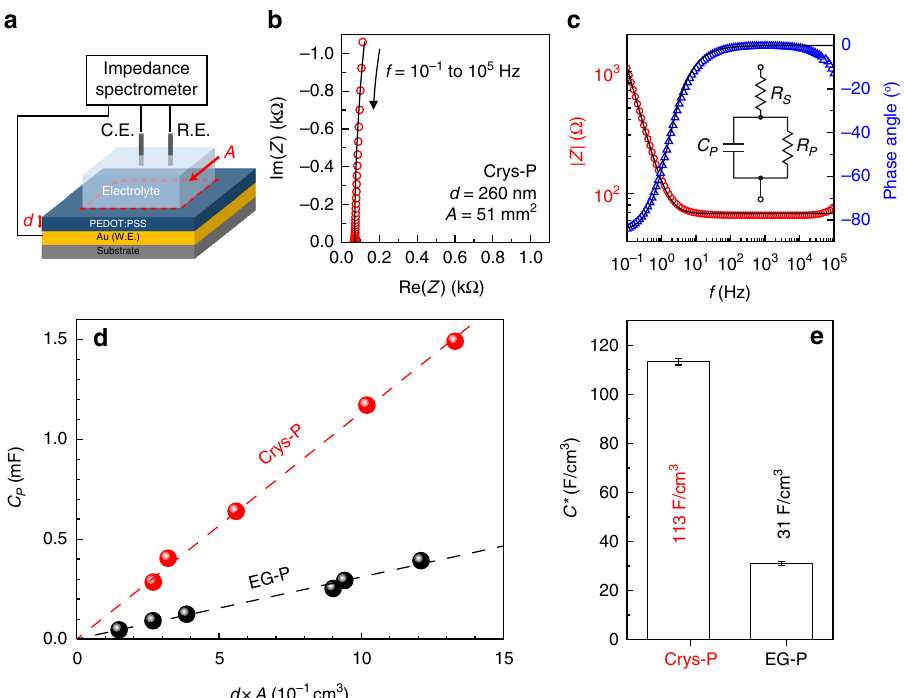
Fig. 4 Electrochemical properties of Crys-P and EG-P fi lms. a A schematic diagram of electrochemical impedance spectroscopy (EIS) measurements (C.E.: counter electrode, R.E. reference electrode (Ag/AgCl), and W.E: working electrode (PEDOT:PSS on Au). The fi lm area and thickness are denoted by ‘ A ’ and ‘ d ’ , respectively. b Nyquist and c Bode plots acquired using the crystallized PEDOT:PSS (Crys-P) fi lm as a working electrode. The EIS data (symbols) was fi tted (black line) with an equivalent circuit model composed of a serial resistor ( R S ), a parallel resistor ( R P ), and a parallel capacitor ( C P ). d Plots of extracted parallel capacitance values as a function of active volume of Crys-P (red circles) and EG-P 5% ethylene glycol-treated PEDOT:PSS (black circles) fi lms. e A bar plot of the volumetric capacitance values which were calculated from the slopes of C P vs. d× A plots in Fig. 4d